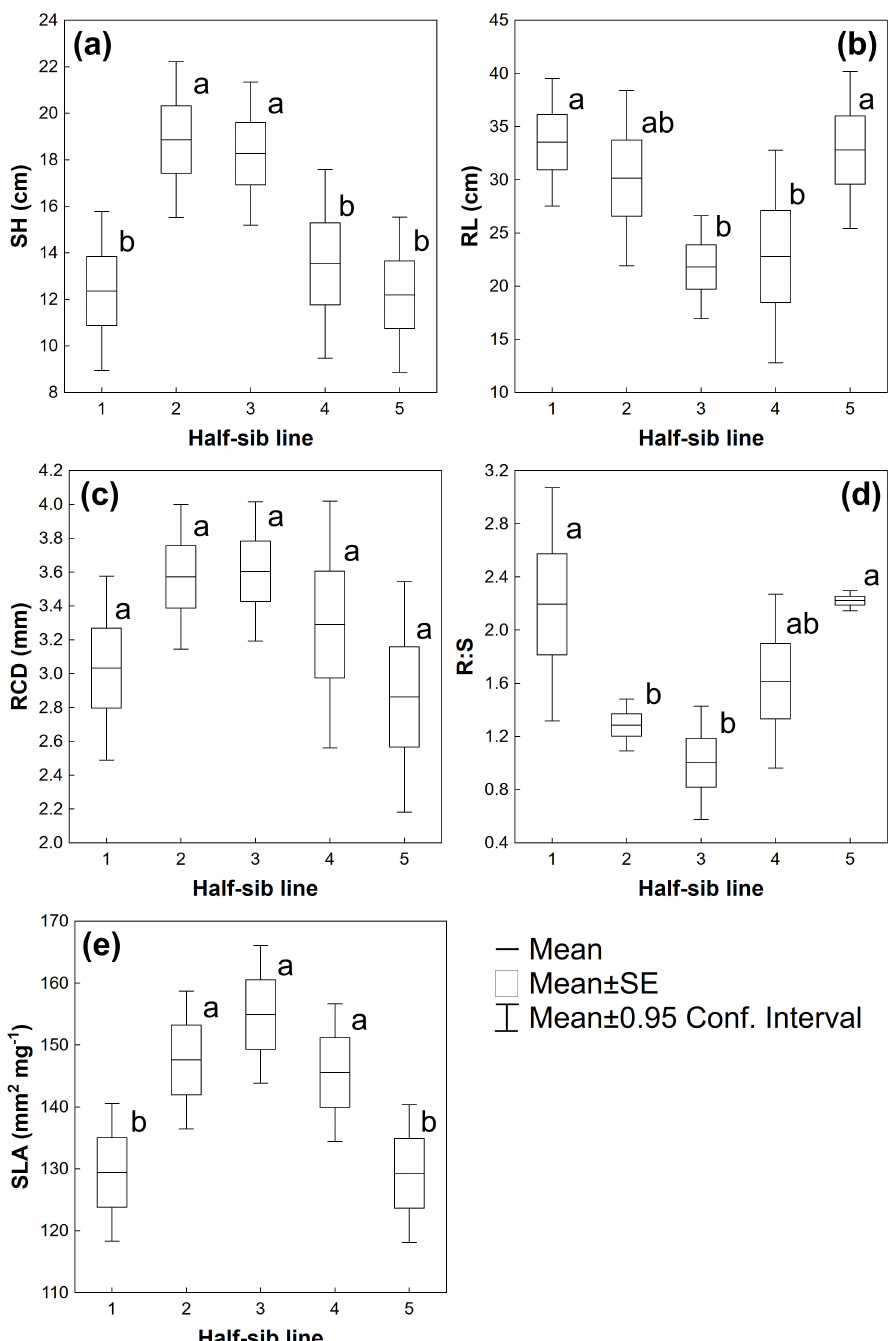
Figure 2. Biometrical traits of Quercus robur L. half-sib lines. ( a ) Seedling height (SH, cm), ( b ) root length (RL, cm), ( c ) root collar diameter (RCD, mm), ( d ) root to shoot ratio of dry mass (R:S), ( e ) specific leaf area (SLA, mm 2 mg − 1 ). Values are means ± standard errors ( n = 9; statistically significant di ff erences among half-sib lines are reported for SH, RL, R:S and SLA) (Dunkan’s multiple range test; p ≤